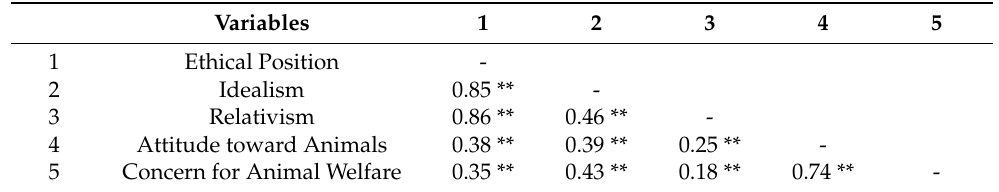
Table 3. Correlation among ethical position, idealism, relativism, attitude toward animals, and concern for animal welfare (N = 450).